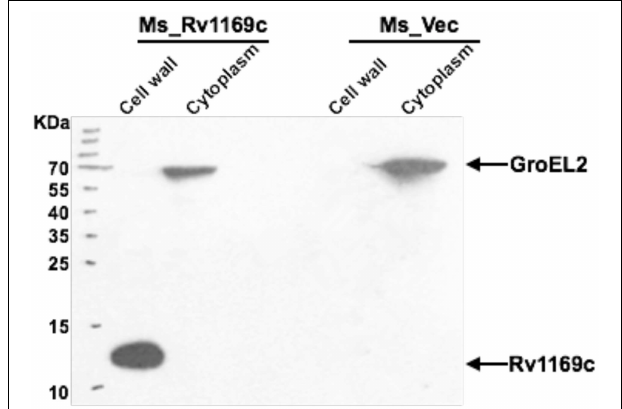
FIGURE 2 | Rv1169c is associated with Mycobacterium cell wall. Cell fractionation experiments were performed to detect detection the expression of Rv1169c protein, and further confirmed by Western blot by specific anti-His antibody. The cytoplasm marker of Mycobacterium GroEL2 served as a control.